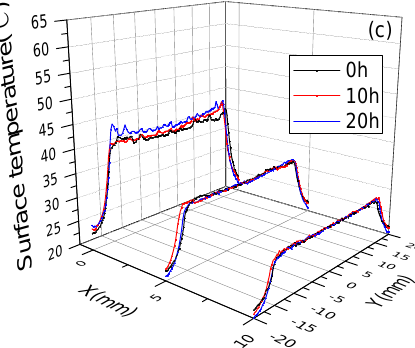
Figure 7. Surface temperature of the dielectrics with 0 min ( a ), 30 min ( b ) and 60 min ( c ) surface fluorination, along the Z ‐ direction at different x position as a function of the aging time ( V pp = 10 kV, f = 6 kHz).